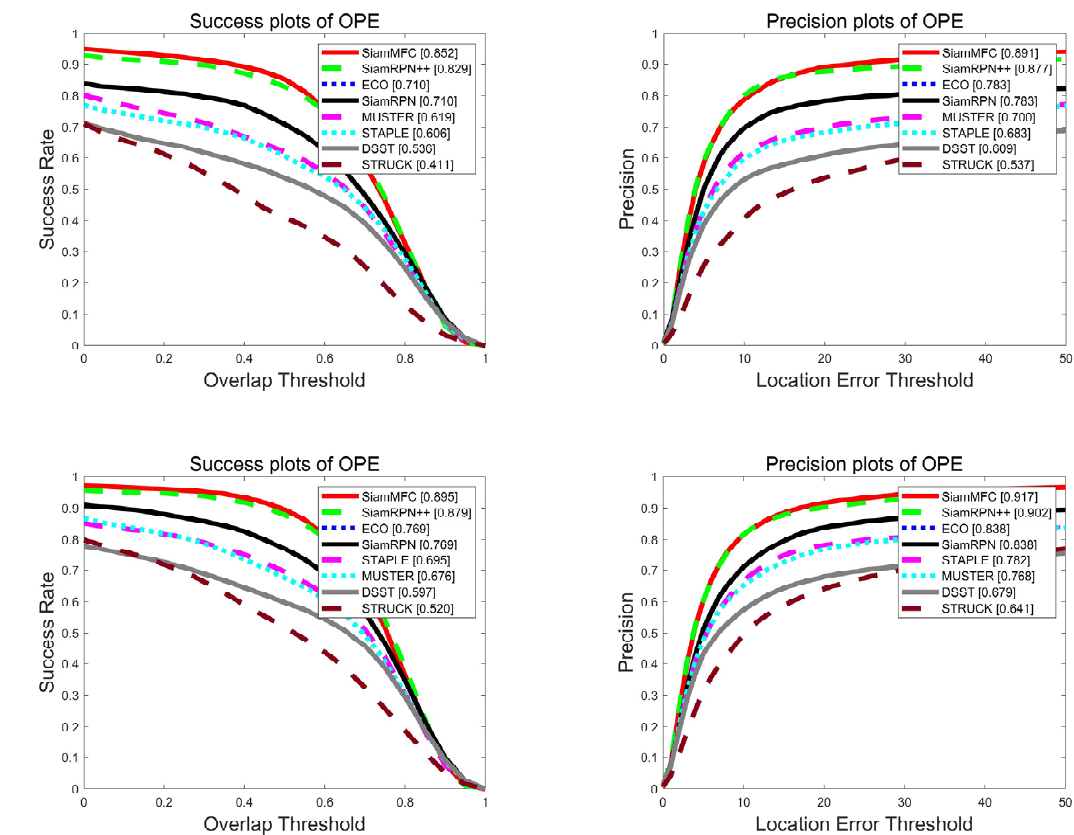
Figure 4. The overall performance comparison plot of the OTB, where the first row is OTB2013 and the second row is OTB2015.